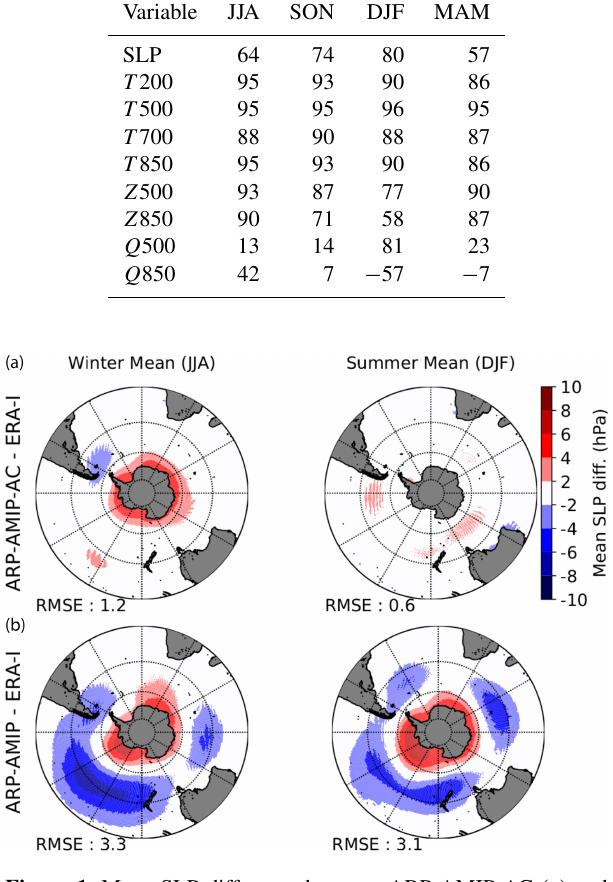
Figure 1. Mean SLP difference between ARP-AMIP-AC (a) and ARP-AMIP (b) simulations minus ERA-I for the reference period 1981–2010 in winter (JJA, left) and summer (DJF, right). Value of the RMSE are given below the